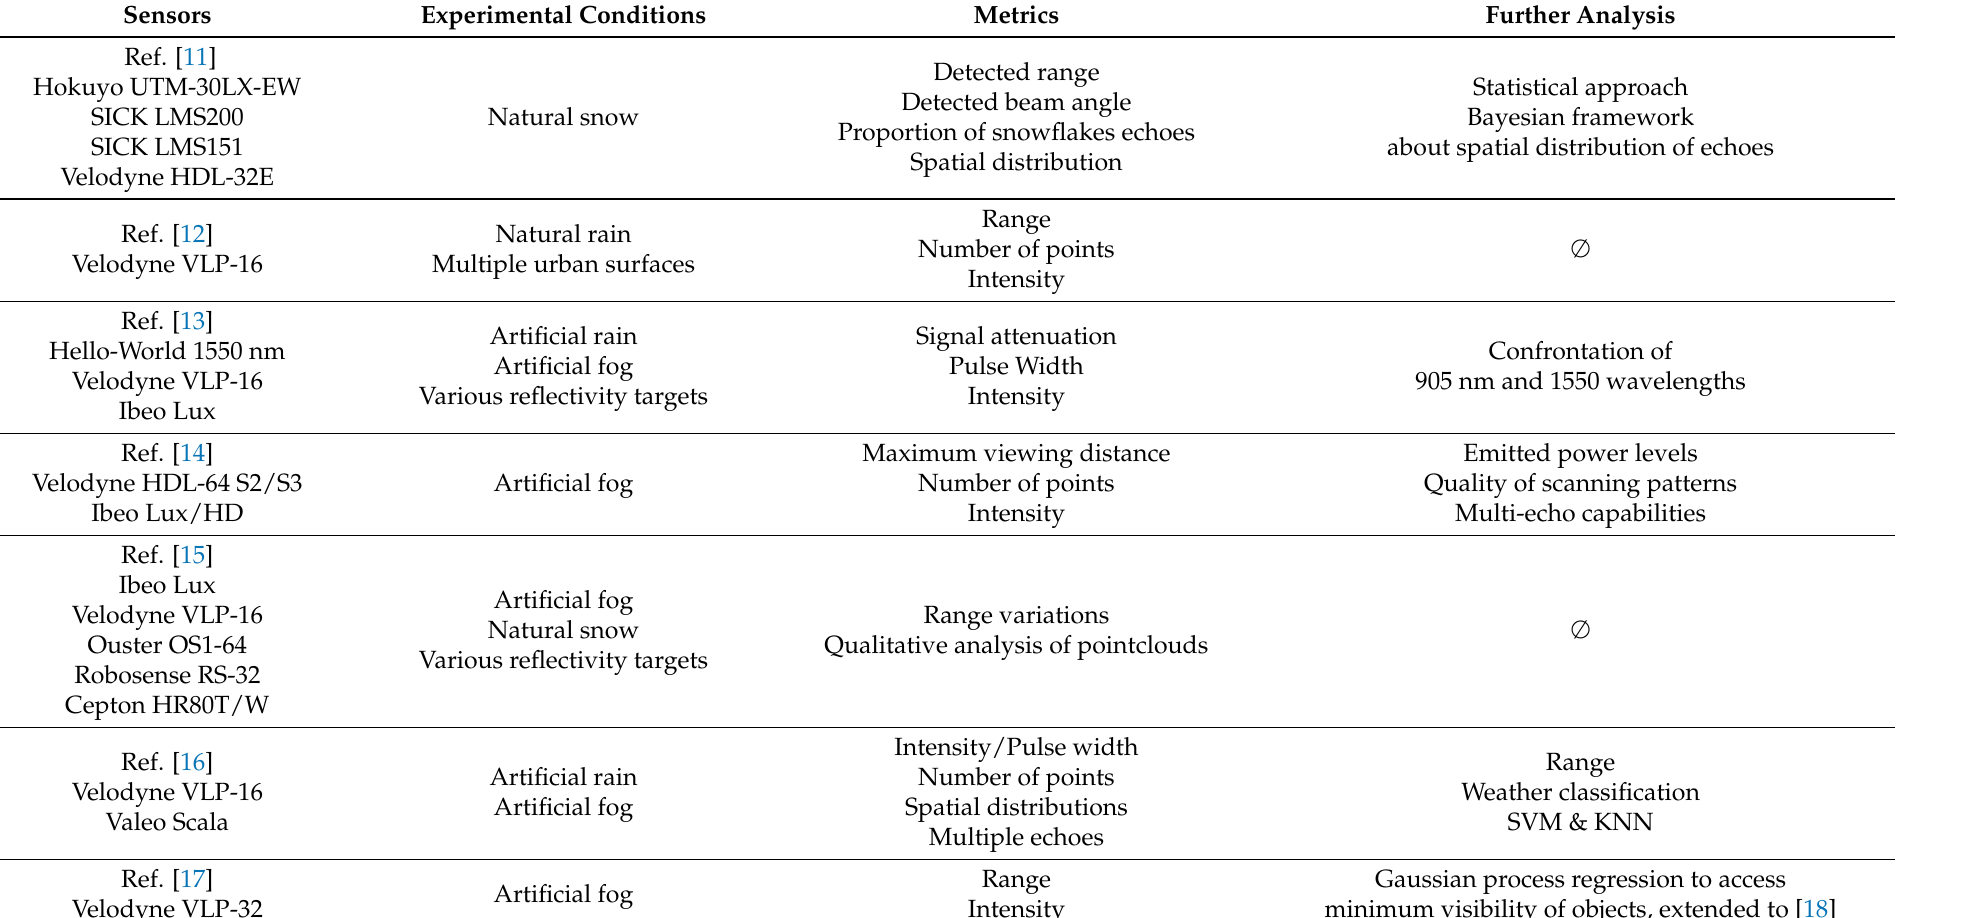
Table 1. Synthesis of experimental analyses of lidars in